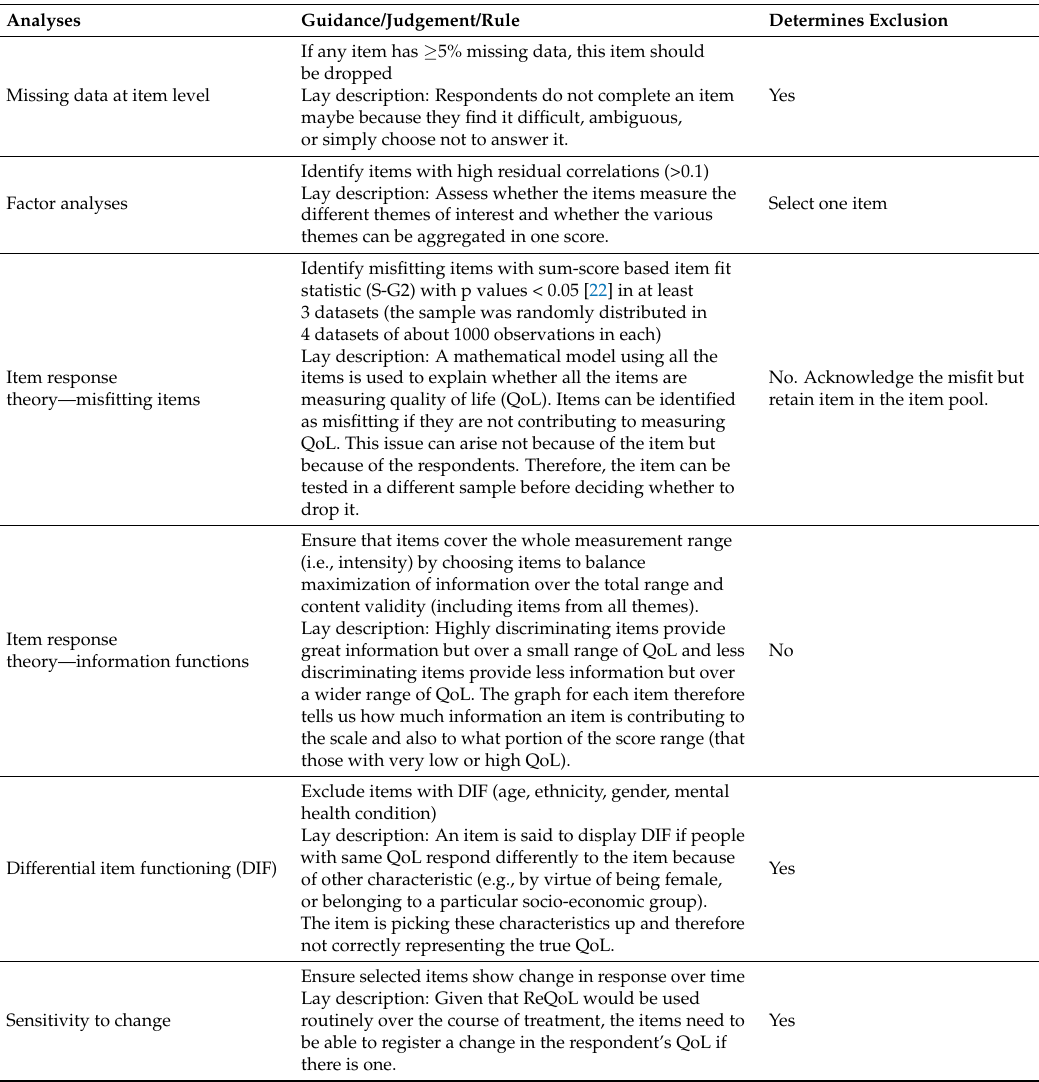
Table 1. Criteria to assess psychometric